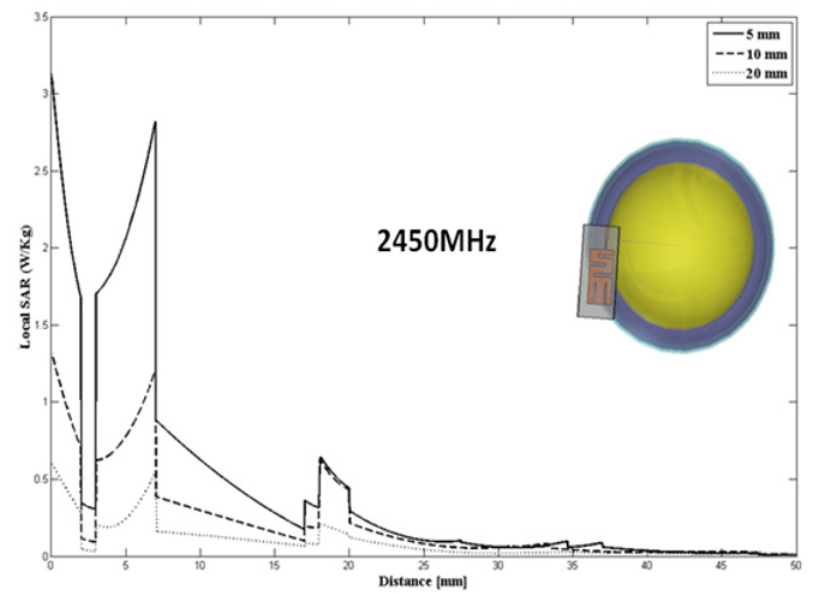
Figure 7. Local SAR variation at different patch antenna-head distances at 2450